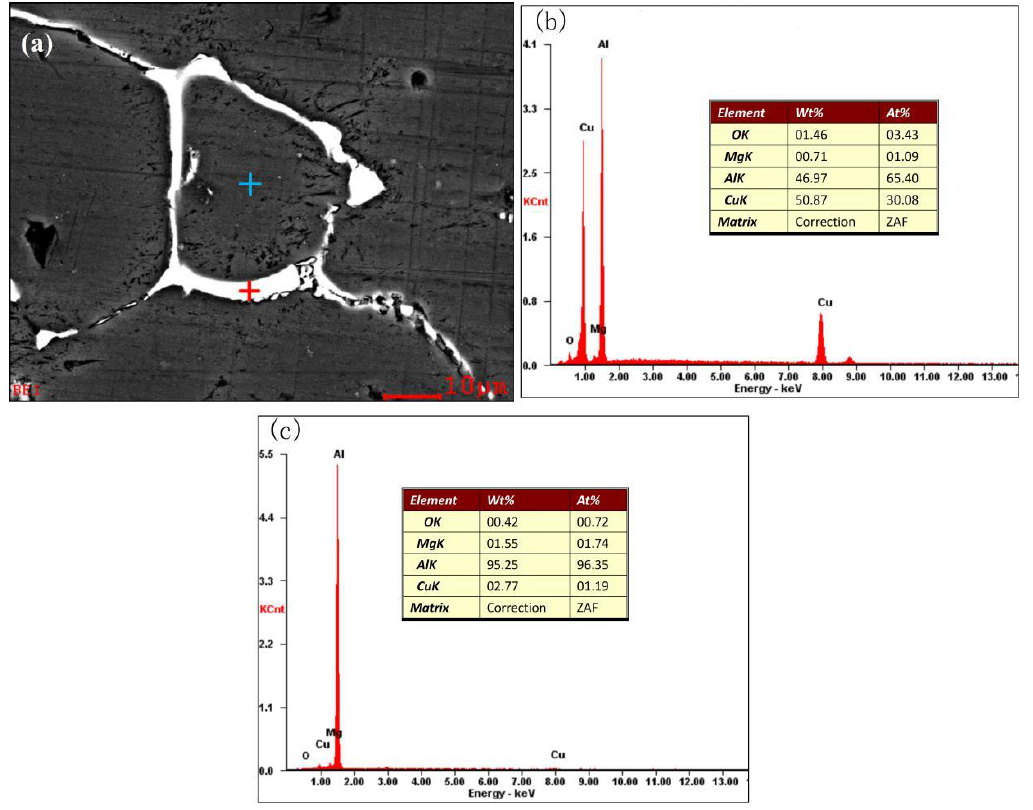
Figure 16. SEM image and EDX analysis of the rheoformed matrix components ( a ) SEM image; ( b ) EDX in location marked with red cross; ( c ) EDX in location marked with blue cross.